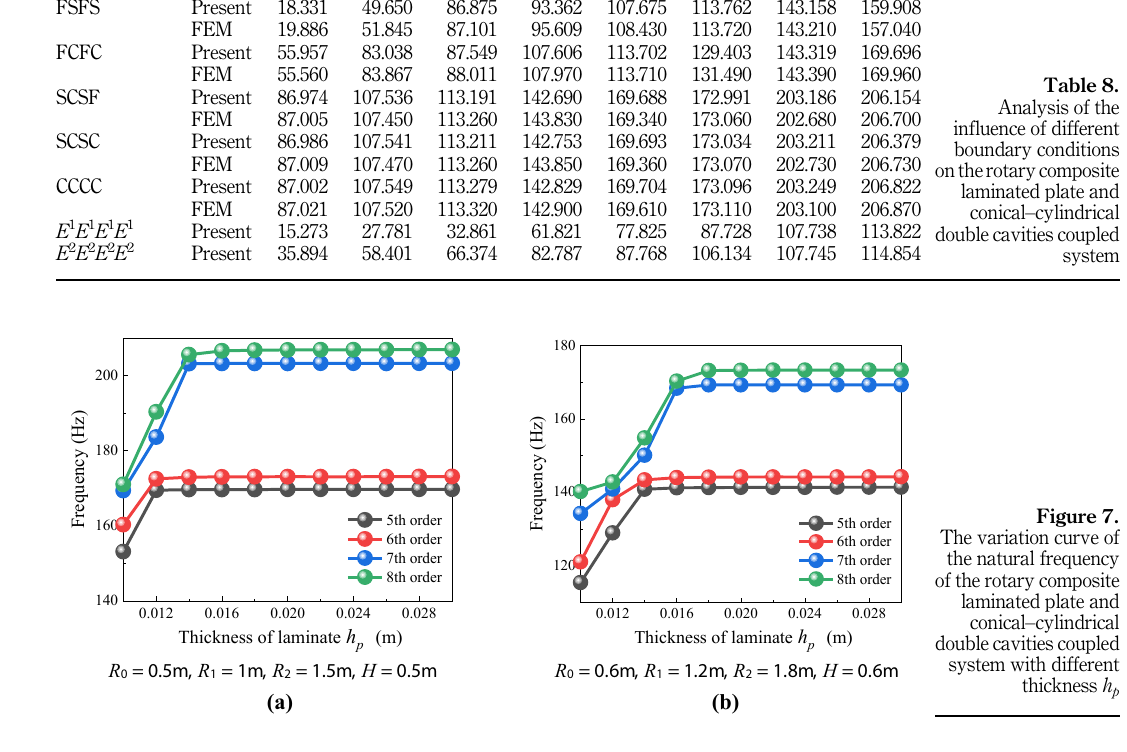
Table 8. Analysis of